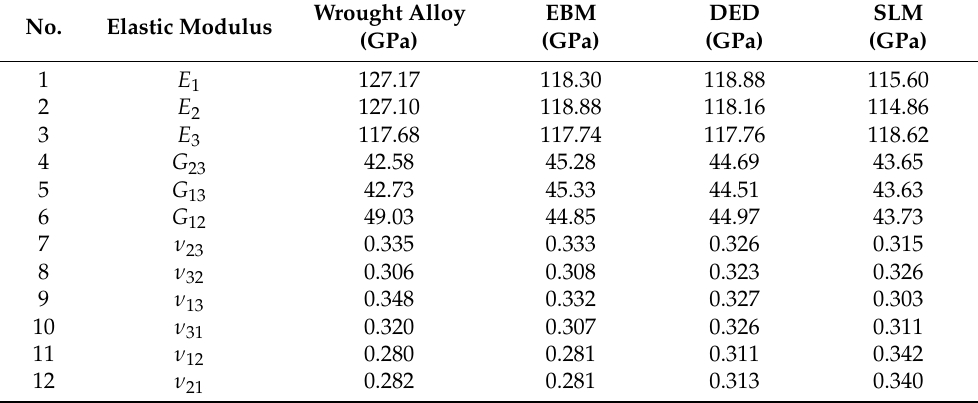
Table 5. The elastic moduli, E ij , of the commercial wrought Ti6Al4V alloy sample and the three AM Ti6Al4V samples ( n = 6). The maximum error (calculated based on the standard deviation and instrumental error) in Young’s moduli E i (i = 1,2,3) is 0.51 GPa, the maximum error in the shear moduli G ij (i,j = 1,2,3, i (cid:54) = j, G ij = G ji ) is 0.28 GPa, the maximum error in Poisson’s ratio ν ij (i,j =